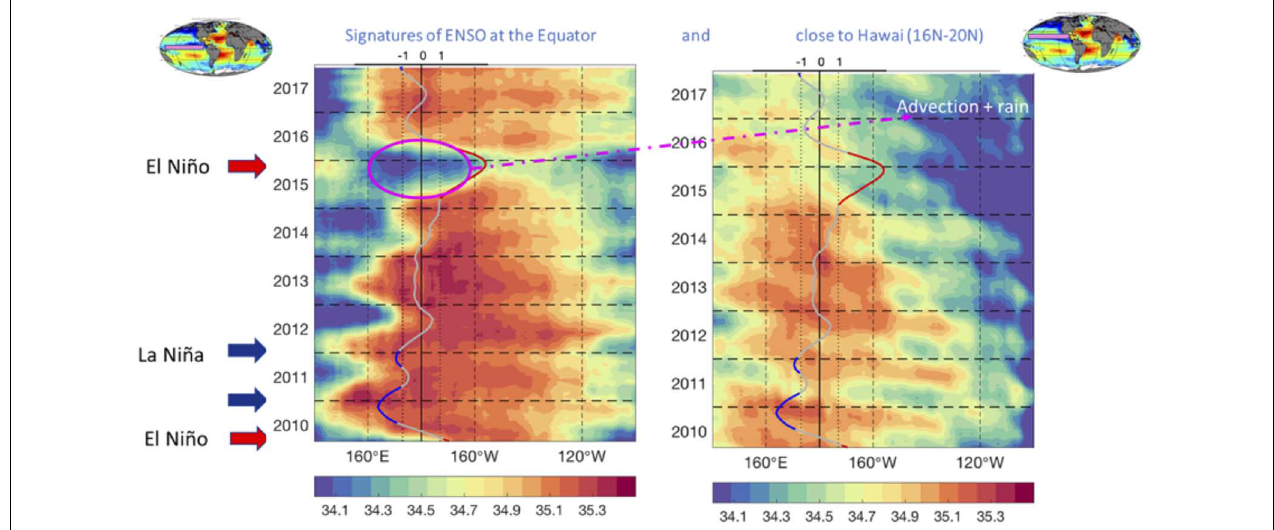
FIGURE 3 | Satellite SSS are used to monitor large-scale events, including ENSO-induced fresh anomalies that are propagated by mesoscale processes. Shown here are time-longitude plots of SMOS SSS, averaged between (left) 2 ◦ S and 2 ◦ N and (right) 16 ◦ N and 20 ◦ N. NINO3.4 index is shown on top of all plots, blue during La Nina and red during El Nino. For the first time, strong negative salinity anomalies that stretch over the tropical Pacific and reach the Hawaii islands have been detected, induced by an extreme El Nino event of October 2015–2016. Modified from Hasson et al.